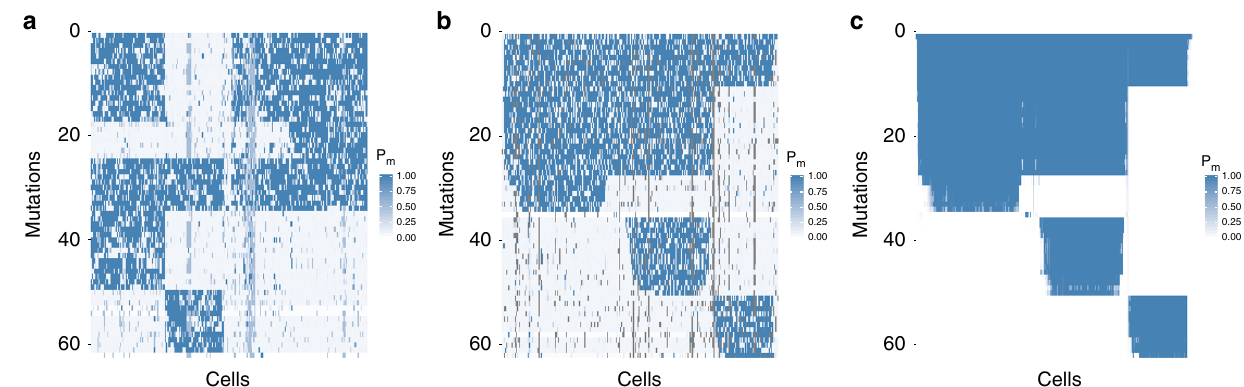
Fig. 5 Summary of the mutation calls from SCI Φ and Monovar on a dataset consisting of 255 cells from a patient (number 3) with acute lymphoblastic leukemia 14 . a Monovar mutation calls for loci identi fi ed as mutated by SCI Φ clustered hierarchically. b Monovar mutation calls clustered according to the tree inferred by SCI Φ . c SCI Φ mutation calls clustered according to its